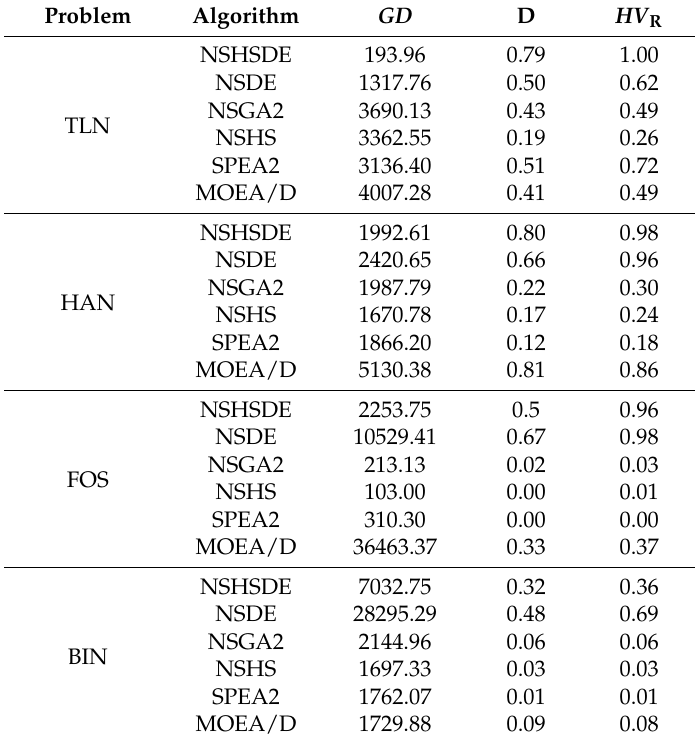
Table 8. Comparison of multi-objective algorithms using the average values of generational